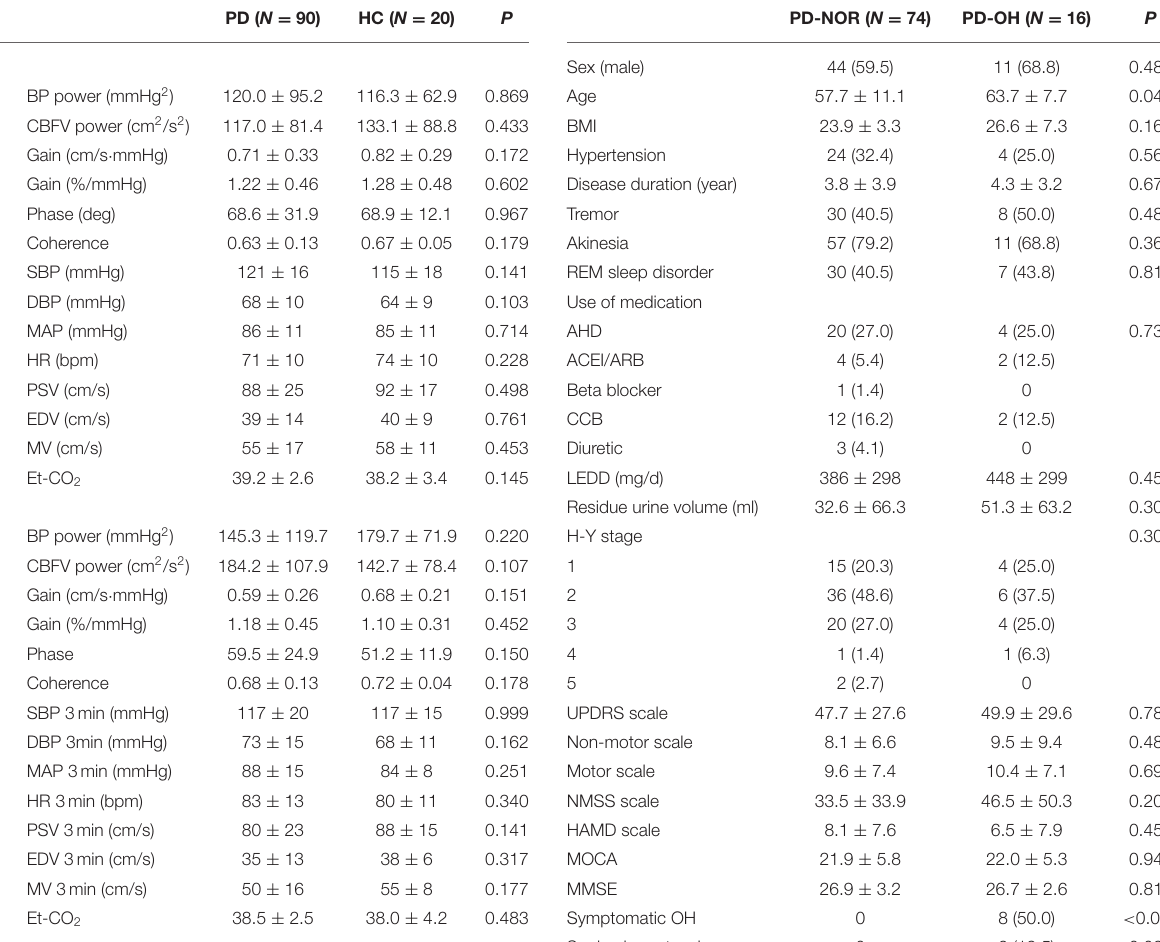
TABLE 3 | Demographic feature of orthostatic hypotension (OH) in patients with Parkinson’s disease